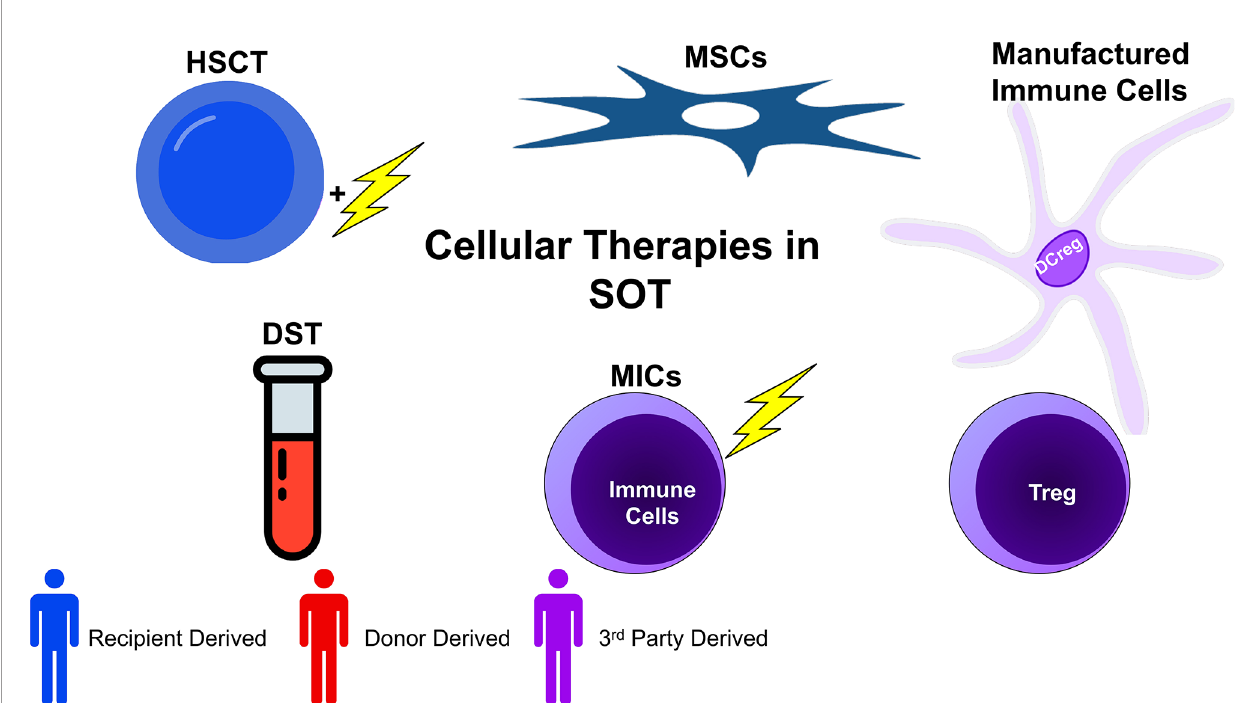
FIGURE 1 | Cellular therapies in transplantation can be broadly categorized into fi ve groups: donor speci fi c transfusions (DSTs), hematopoietic stem cell transplant (HSCT), mesenchymal stem cell based therapy (MSC), manufactured immune cell therapy (using various regulatory cells), and modi fi ed immune cell (MIC) therapy. These broad categories can be further subdivided by the source of the cells. Whereas recipient derived cells carry no risk of sensitization (or very little), donor derived cells inherently may sensitize the recipient. Additionally, 3 rd party cells, depending on their genetic similarity with donor and recipient, may or may not be sensitizing. When evaluating cellular therapies, both the function and origin of cells are of